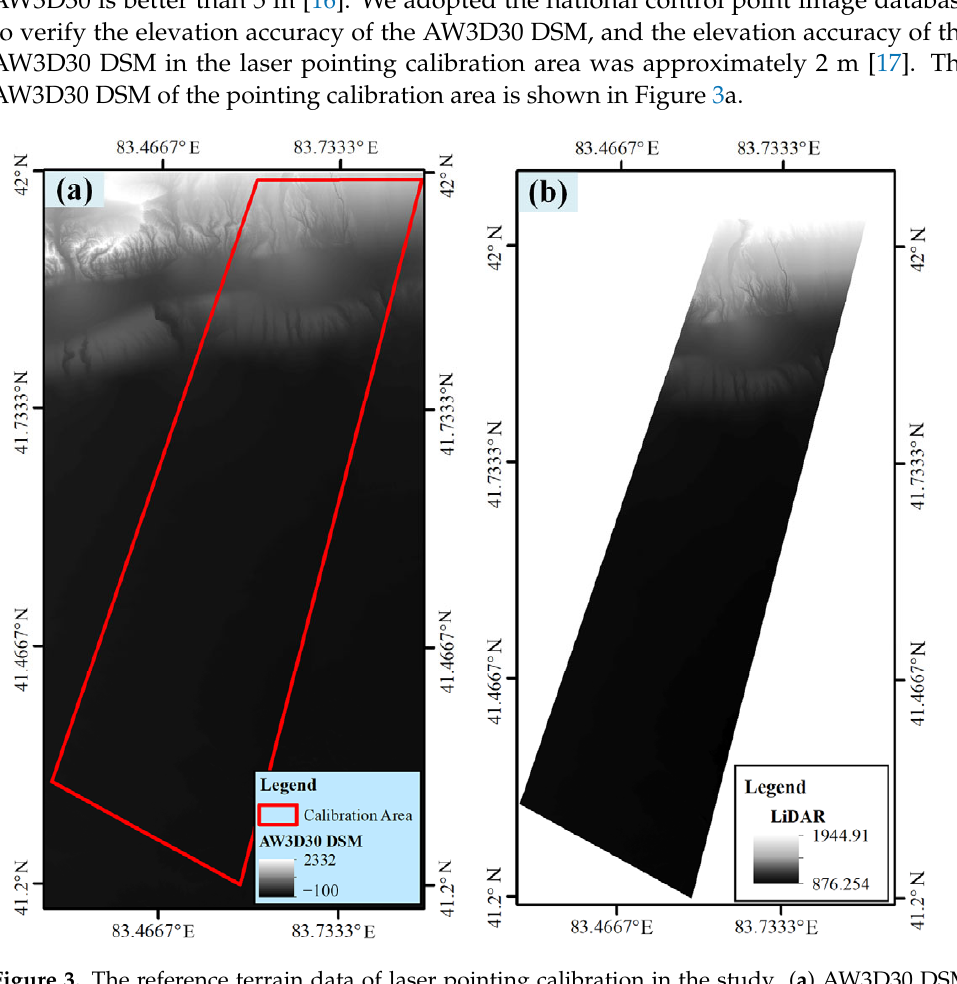
Figure 3. The reference terrain data of laser pointing calibration in the study. ( a ) AW3D30 DSM. ( b ) LiDAR